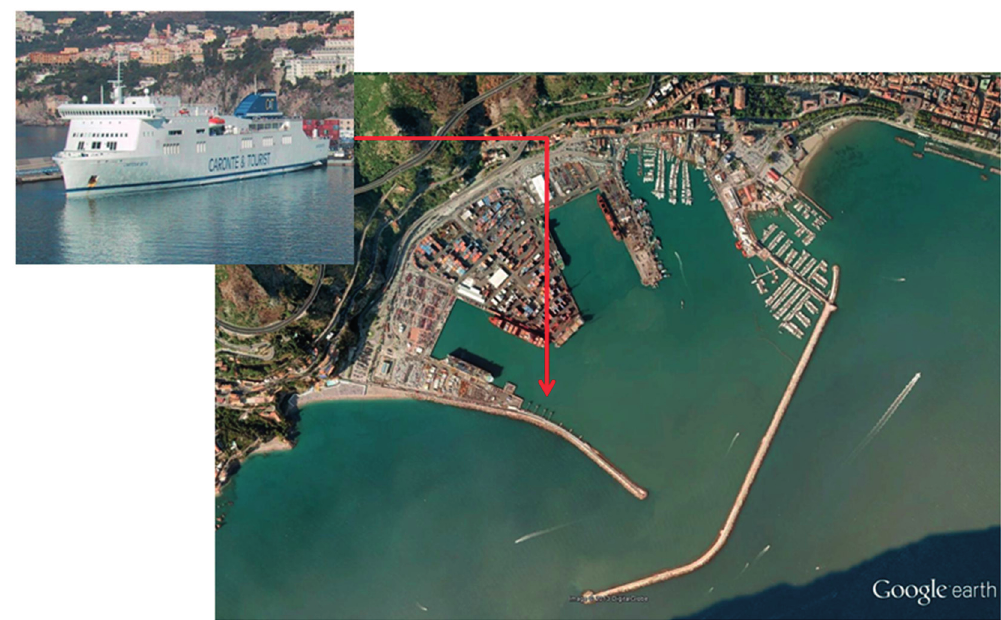
Figure 2. A view of Salerno Harbour and its two main jetties. The red arrow denotes the position of the acquisition system installed on the Caronte & Tourist ferry ship.